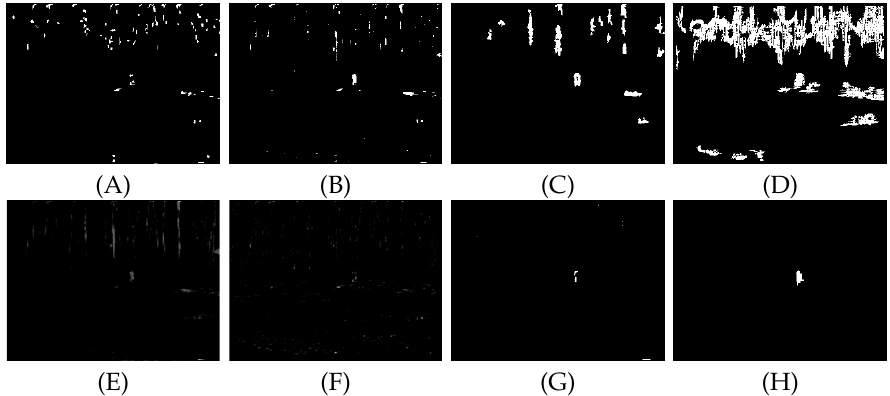
Figure A10. ( A – H ) shows the detection results of eight algorithms PSTNN, TV-PCP, VNTFR, anisotropy, ASTTV, SRWS, RPCA and propose method, respectively, under sequence D.